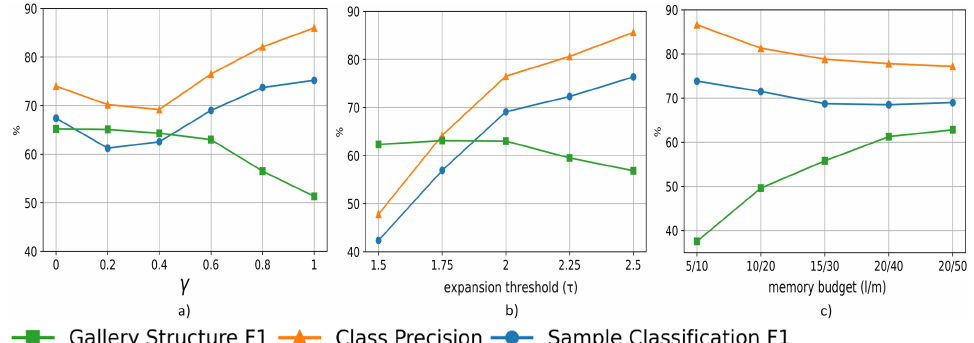
Figure 4. Parameter evaluation in the gallery construction process using the MARS dataset: ( a ) effect of the weight assigned to uncertainty and diversity ( γ ); ( b ) influence of the expansion threshold ( τ ); ( c ) effect of the minimum size to create a class and the memory budget ( l / m ).